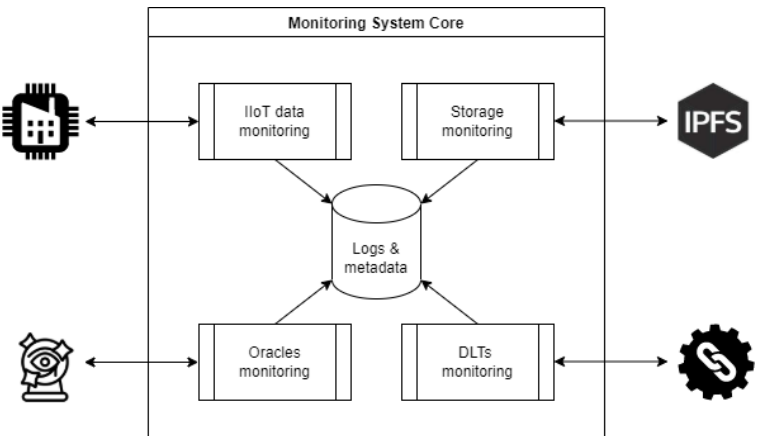
Figure 5. Monitoring system